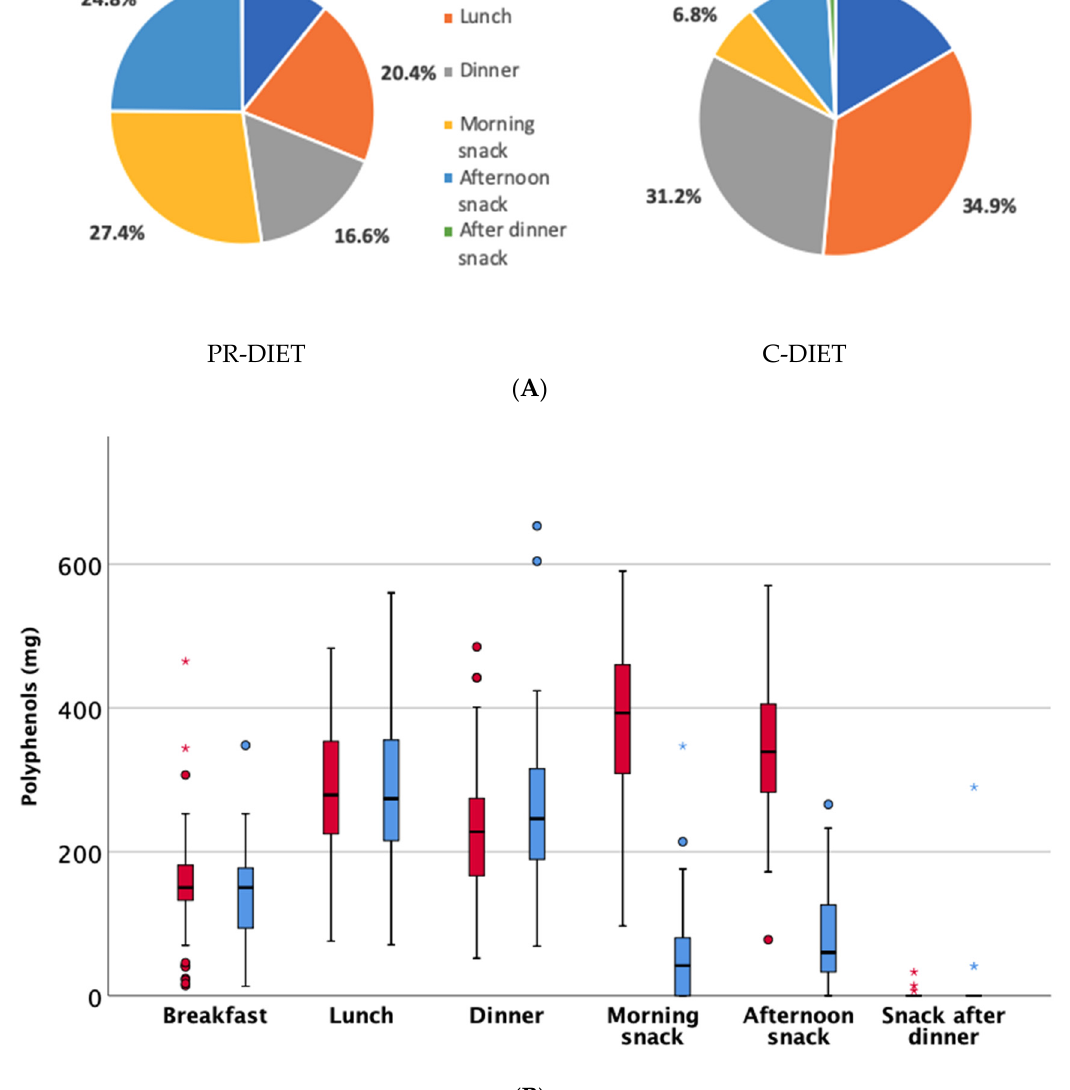
Figure 3. Total phenolic contribution from di ff erent meals during the polyphenol (PR)-diet and the control (C)-diet expressed as percentage (Panel A ), or expressed as amount in mg during the PR-diet (in red) and the C-diet (in blue) as estimated through PE / USDA databases and other published data (Panel B ). Dots represent mild outliers that are more extreme than Q1 − 1.5 * IQR or Q3 + 1.5 * IQR but are not extreme data. Asterisks are extreme data that are more extreme than Q1 − 3 * IQR or Q3 + 3 * IQR (where Q1 = quartile 1; Q3 = quartile 3; IQR = interquartile